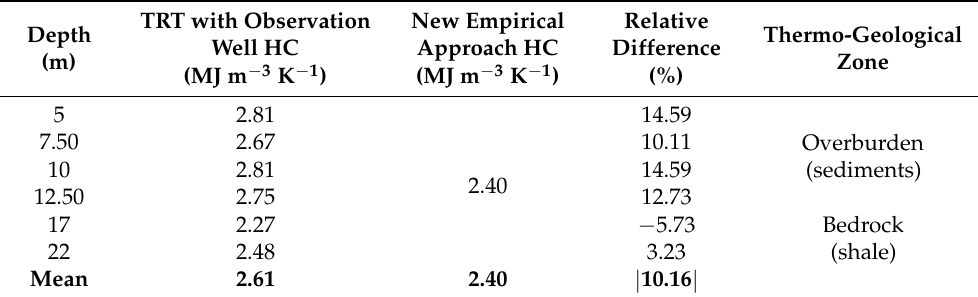
Table 3. Subsurface HC inferred with the new empirical method compared to the results obtained by [11] using the dual needle concept at the INRS experimental site. Mean values of each method and mean relative difference in bold.